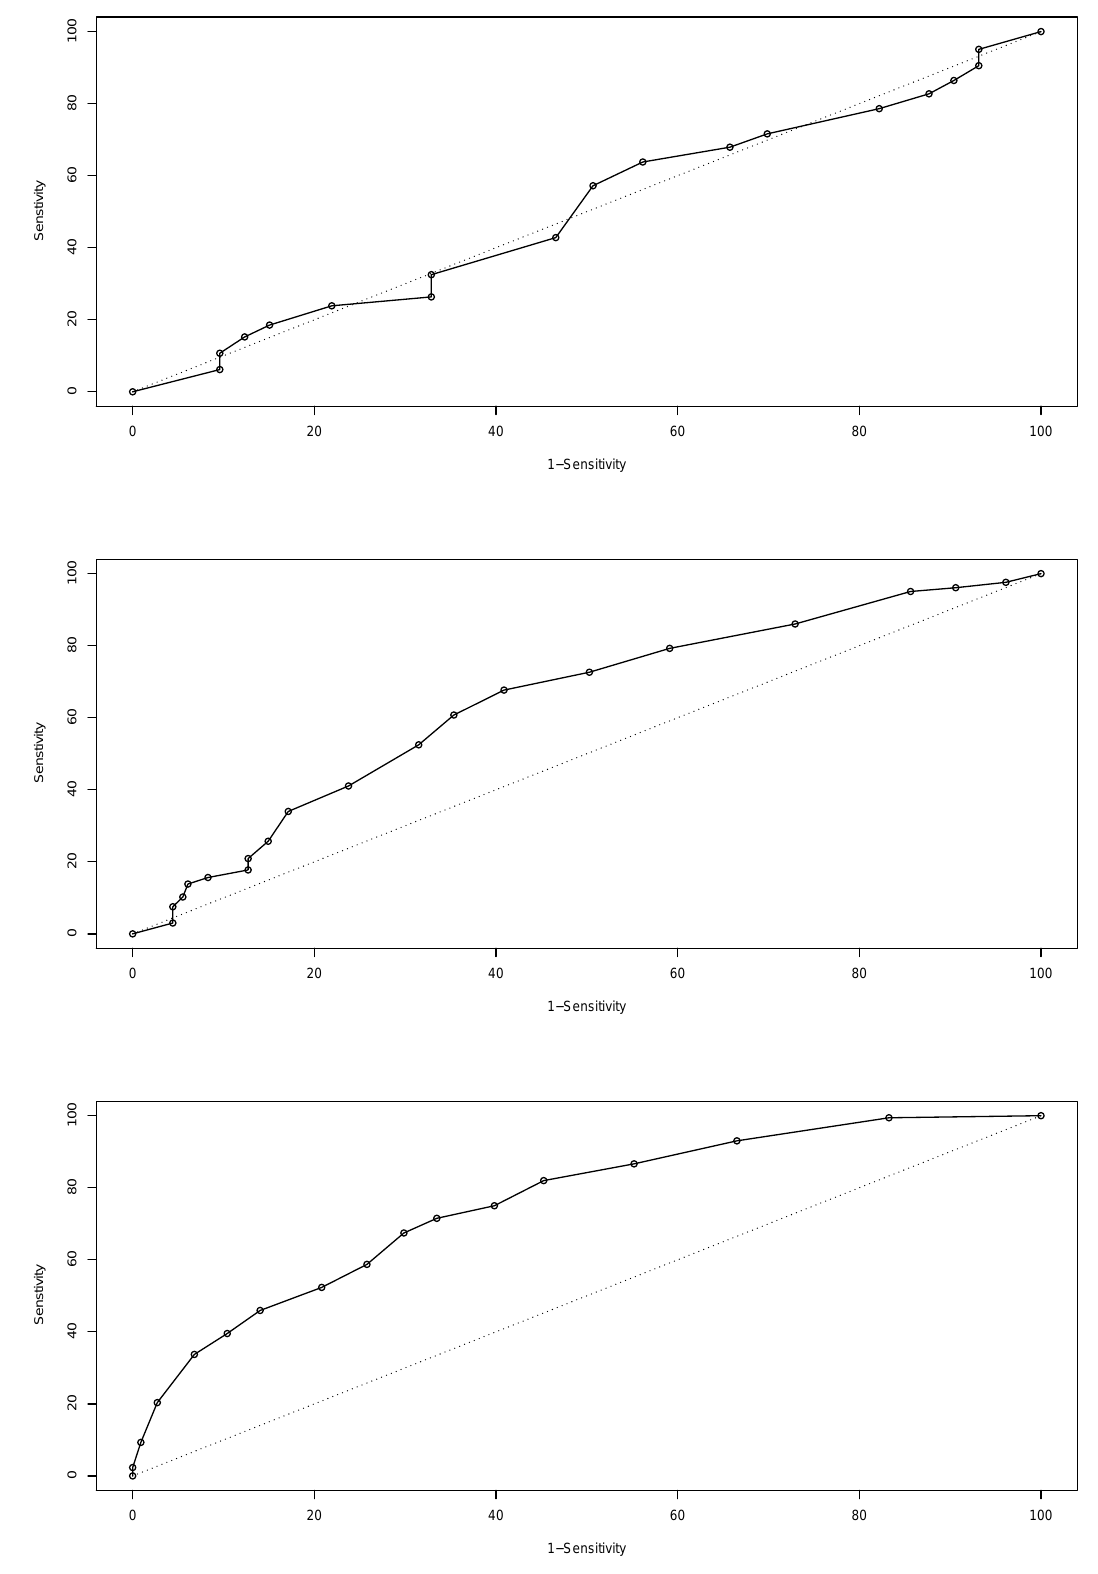
Figure 6. Receiver operating characteristic (ROC) curves for ICES only ( top ), ICES with habitat classes ( middle ) and ICES with biotopes ( bottom )